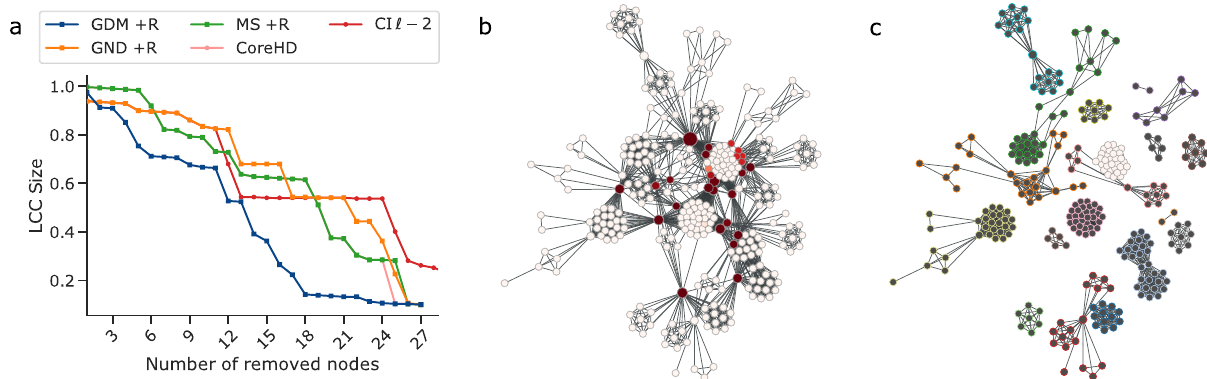
Fig. 2 Dismantling the Brazilian corruption network. a GDM and state-of-the-art algorithms with reinsertion of the nodes are compared. The network before ( b ) and after ( c ) a GDM attack is shown. The color of the nodes represents (from dark red to white) the attack order, while their size represents their betweenness value. In the attacked network, darker nodes do not belong to the LCC, and their contour color represents the component they belong